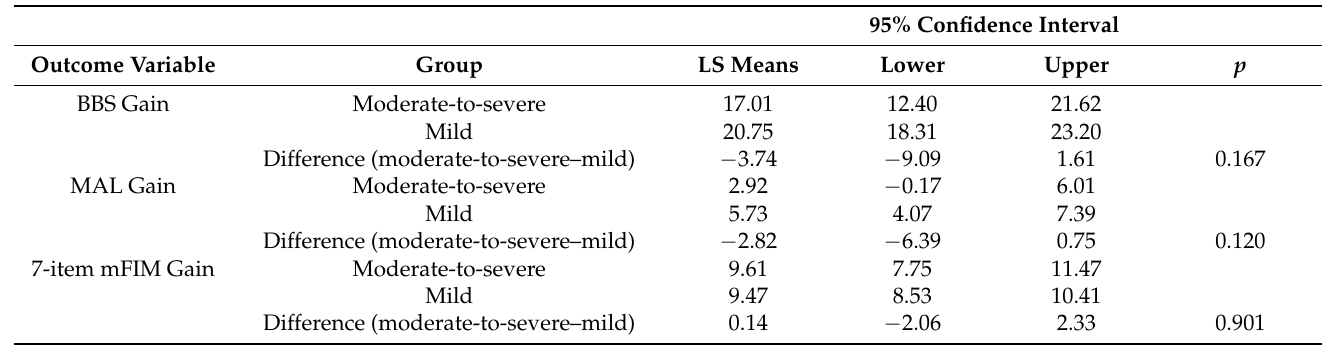
Table 7. LS means for the category of neglect severity (patients with mild SN vs. patients with moderate-to-severe